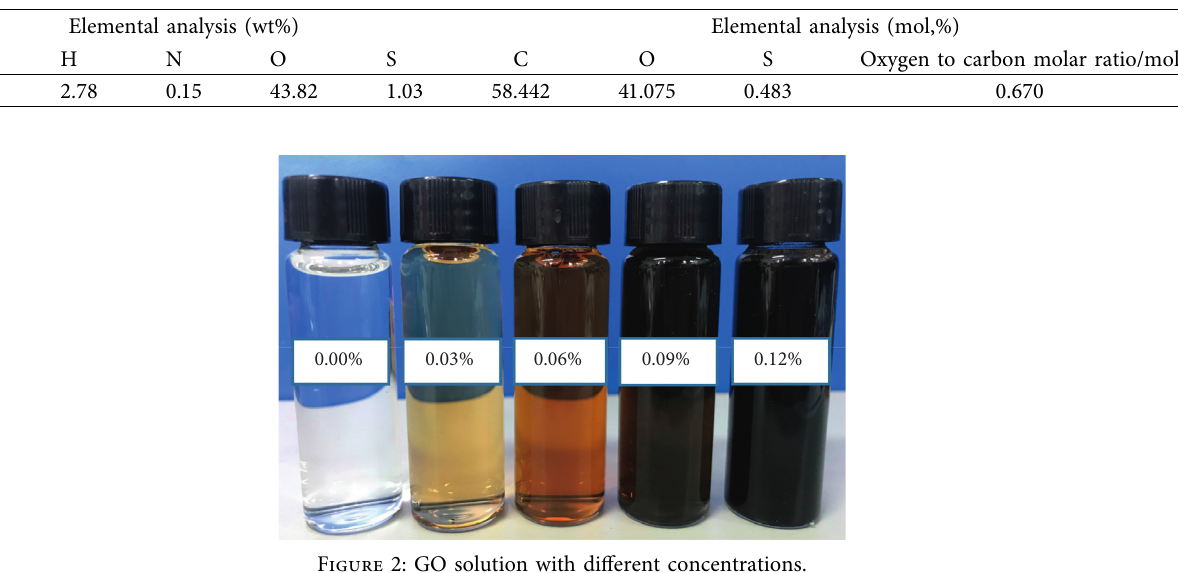
Table 5: Element analysis of GO.